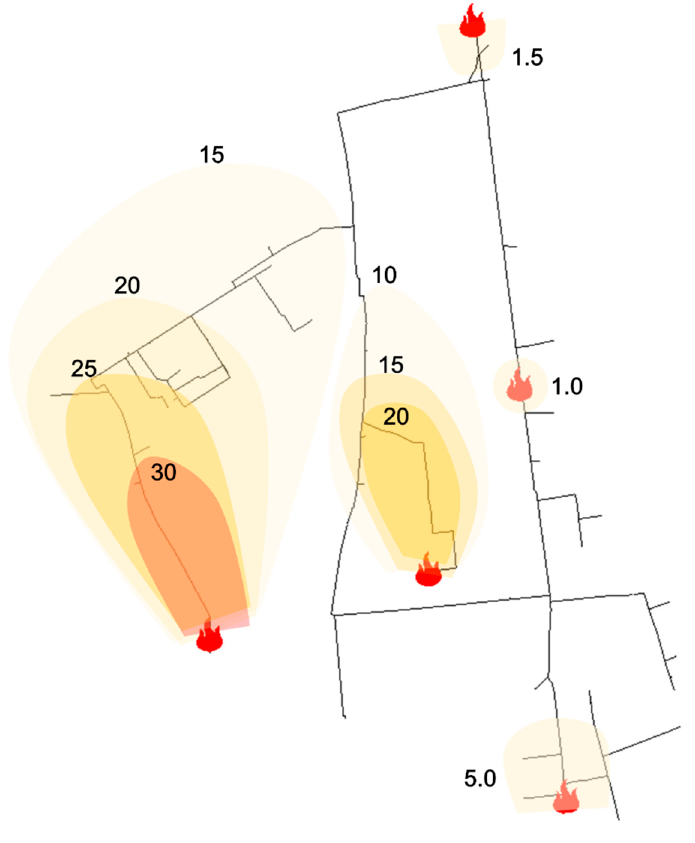
Figure 13. The average length of the error in relation to the fractal dimension and the number of monitoring sensors applied.